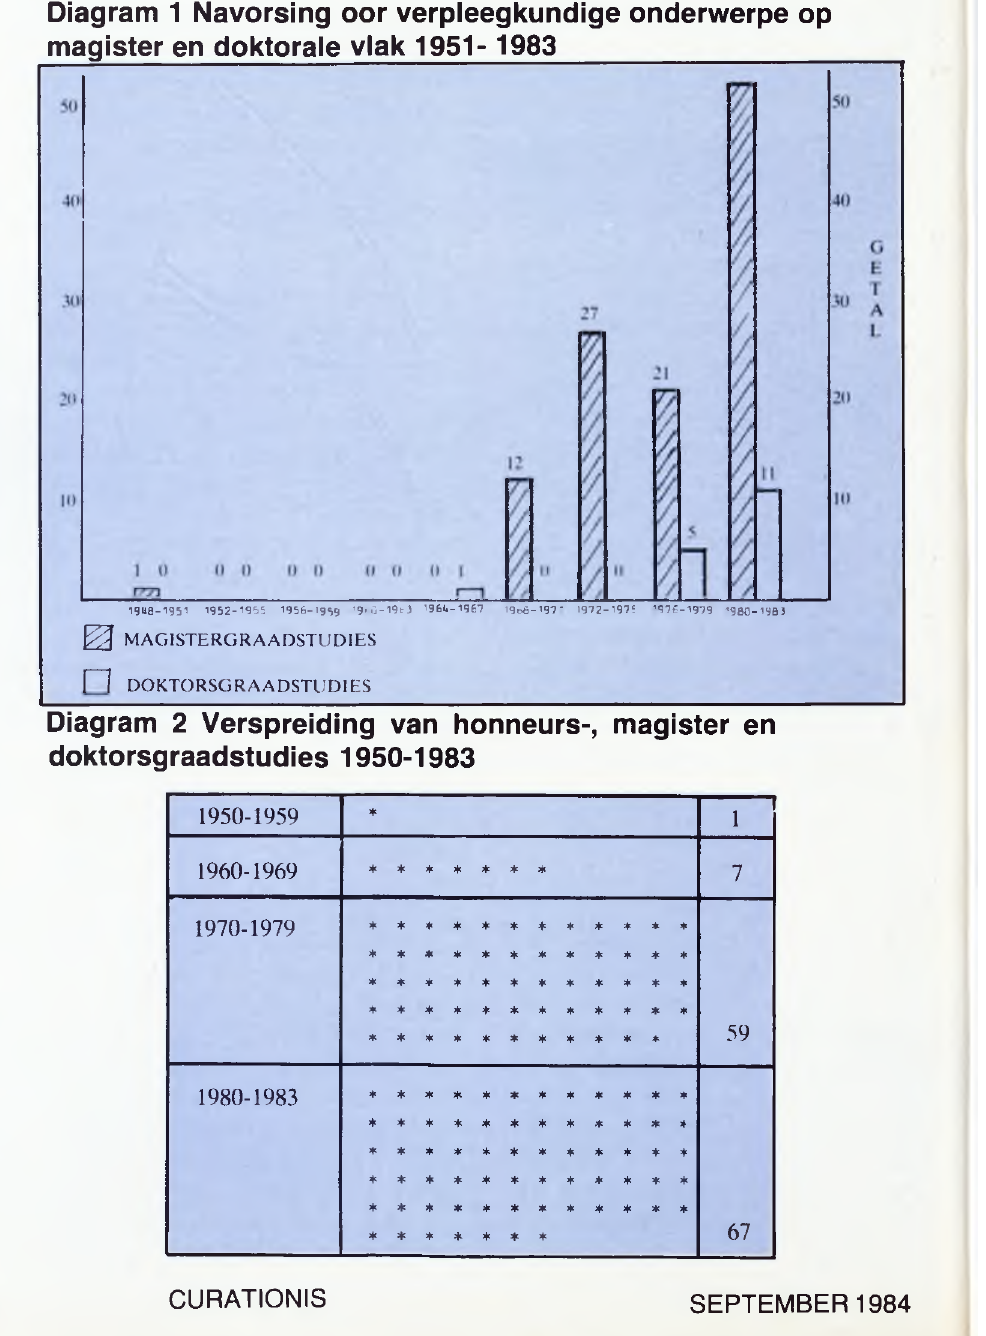
Diagram 1 Navorsing oor verpleegkundige onderwerpe